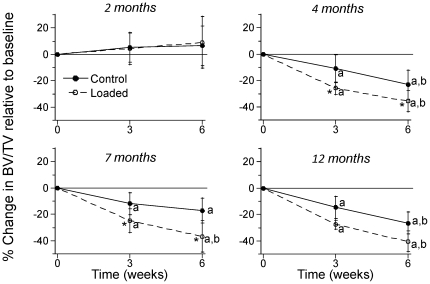
Mechanical loading decreases trabecular bone volume in older mice.Trabecular bone volume fraction (BV/TV) decreased in legs of 4, 7 and 12 month old mice subjected to axial tibial compression. BV/TV was assessed in the proximal tibias of loaded and contralateral control limbs using in vivo microCT at the study baseline (0 weeks), middle (3 weeks) and end (6 weeks). Percent change in BV/TV was computed relative to the value at baseline. Significant temporal decreases were observed in mice aged 4, 7 and 12 months, with greater declines in loaded limbs than controls. (n = 7–9; mean ± SD; * loaded different from control; a: change in BV/TV is different from 0 weeks; b: change in BV/TV is different from 3 weeks, p<0.05).